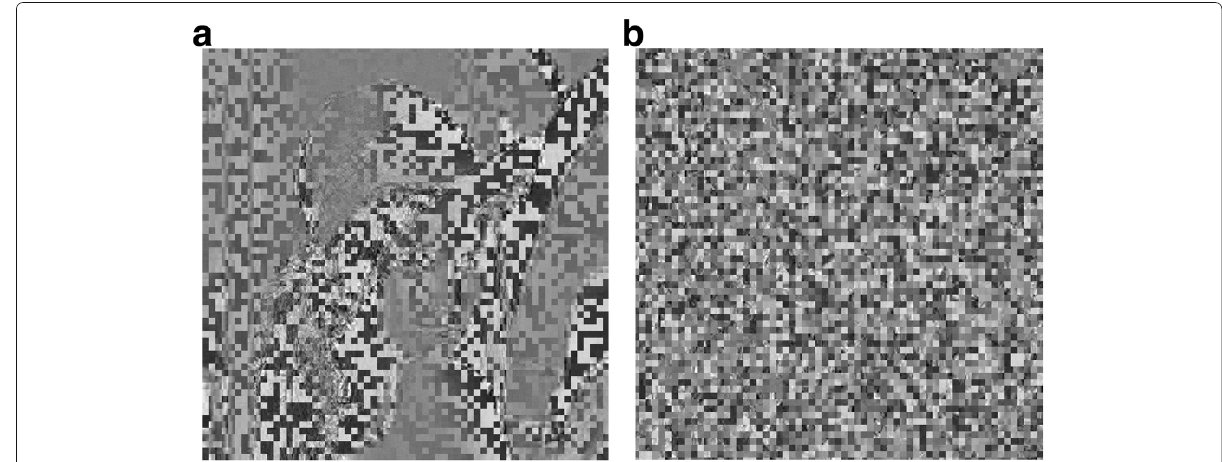
Fig. 4 Encrypting the marked Lena image in the DCT domain. a Coefficient sign bit encryption. b Permutation of 8 × 8 blocks